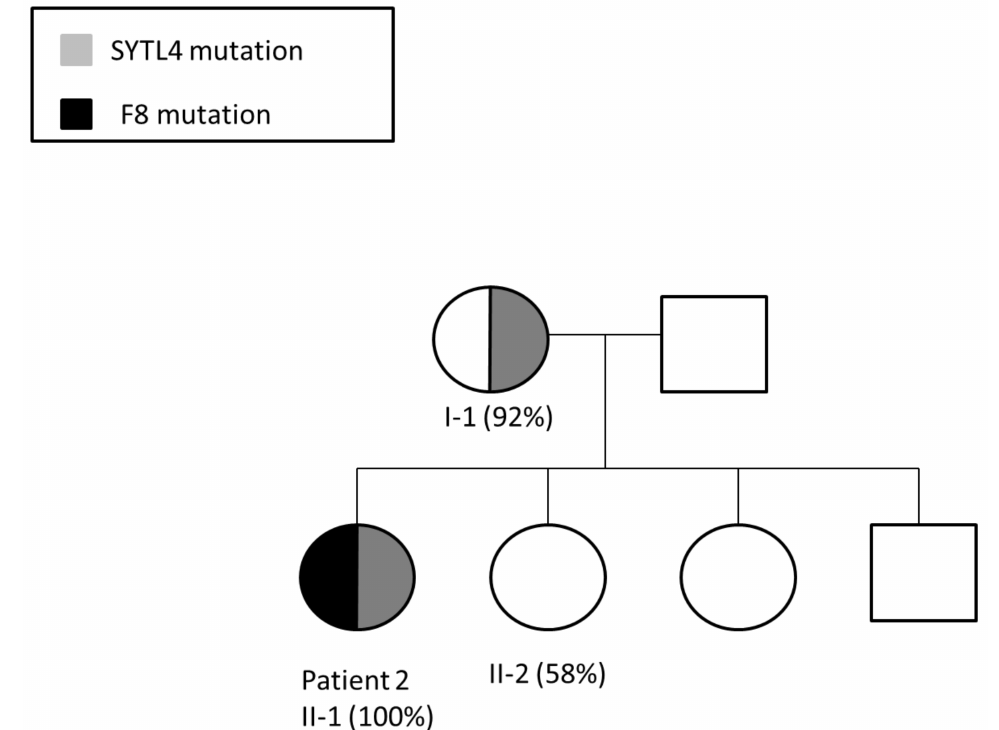
Figure 4. Segregation of F8 and SYTL4 mutations in the pedigree of patient 2, demonstrating two generations of skewed inactivation of the X chromosome bearing the mutant SYTL4 gene (%XCI is indicated in parentheses). Both patient 2 (II-1) and her mother (I-1) demonstrate skewed inactivation of the same X chromosome. Patient 2 presents with HA phenotype due to de novo F8 intron 22 inversion, which occurred on her paternal X-chromosome and skewed inactivation of the X chromosome bearing the mutant SYTL4 gene inherited from her mother. The patient’s son inherited the X chromosome bearing the F8 intron 22